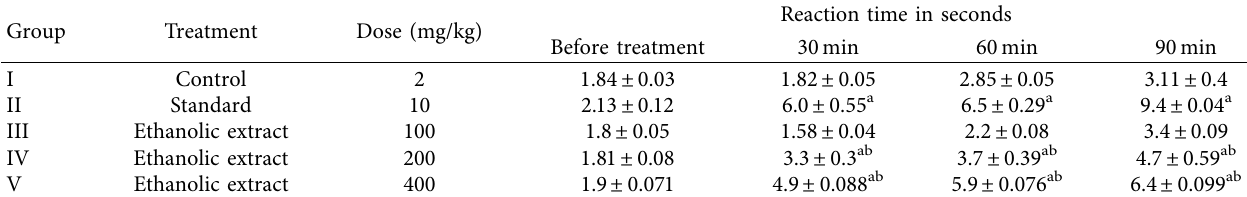
Table 5: Efect of ethanolic extract of Artocarpus hirsutus Lam on tail immersion method. Group